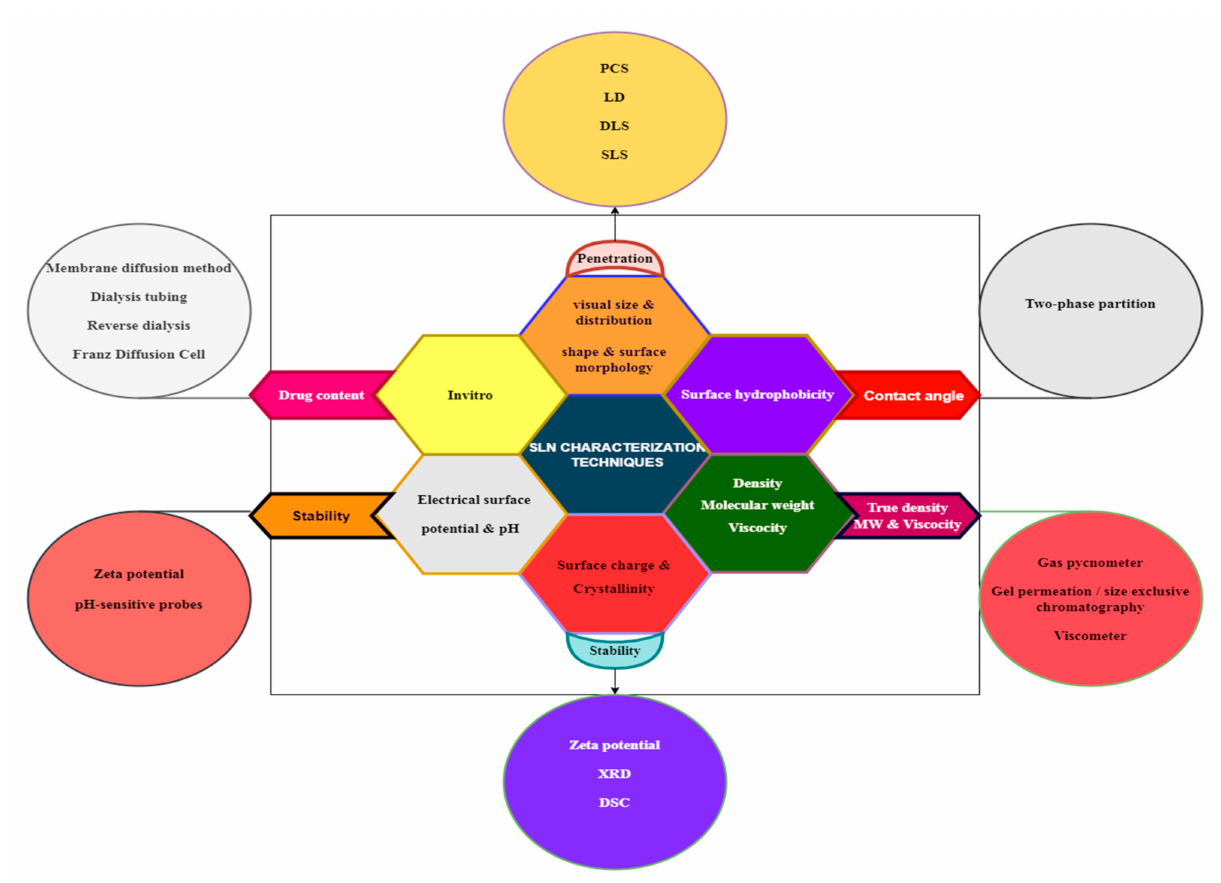
Figure 6. Characterization parameters.